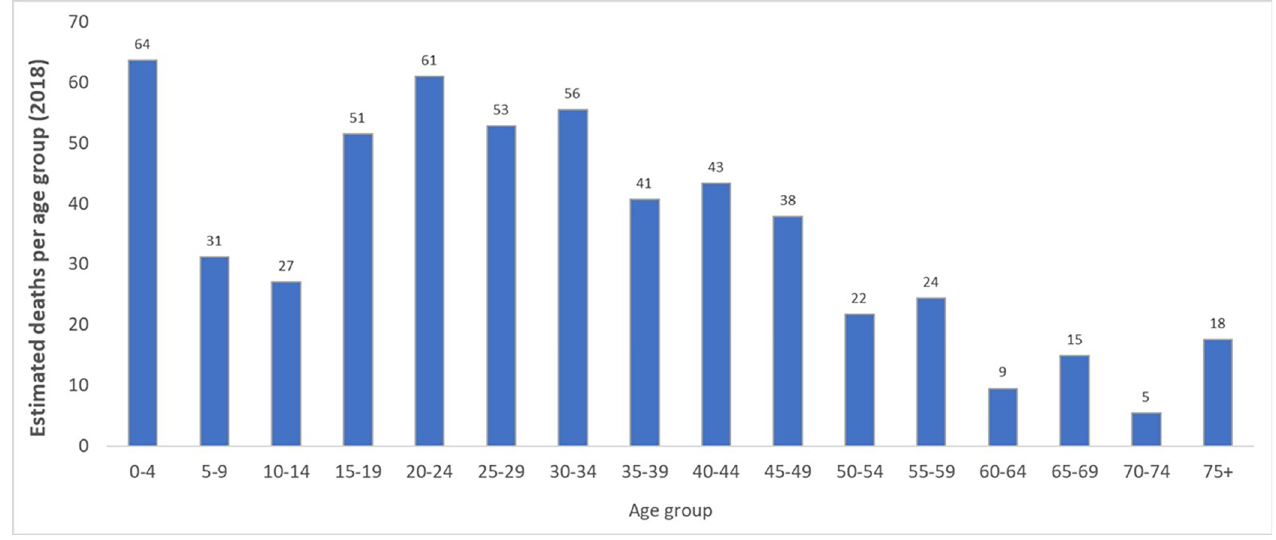
Fig 1. Estimated number of deaths per age group among SCD patients.